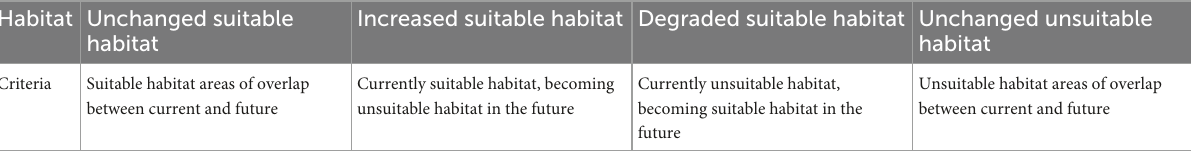
TABLE 2 Evaluation criteria for suitable habitat changes in the future. Habitat Unchanged suitable habitat